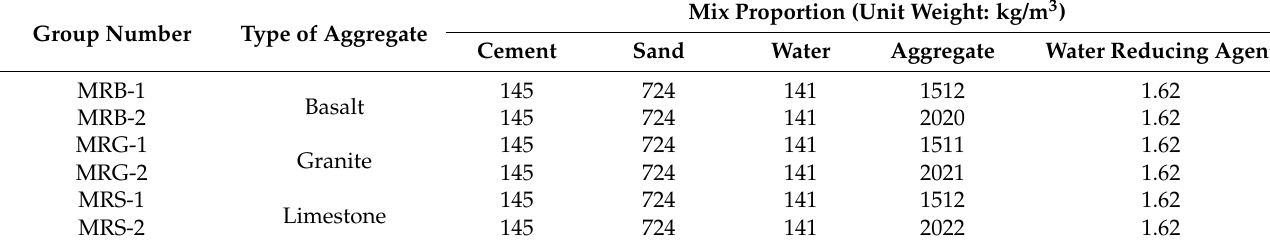
Table 4. Design of cubic specimen mix ratio.